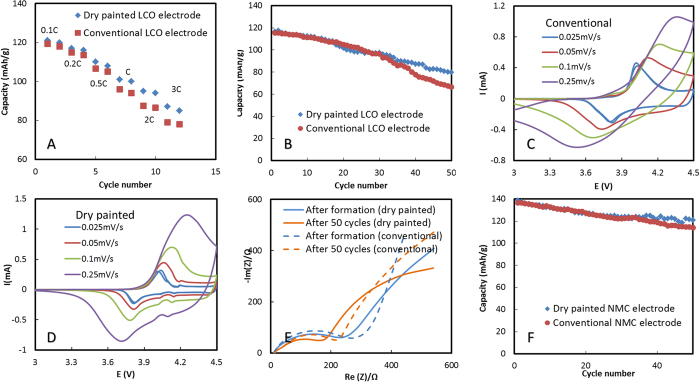
Electrochemical Characterization.(A) C-rate performance of the dry painted and conventional LiCoO2 (LCO) electrodes, (B) cycling performance comparison between the dry painted and conventional LCO electrodes; (C) Cyclic Voltammetry of conventional LCO electrodes; (D) Cyclic Voltammetry of dry painted LCO electrodes; (E) Comparison of electrochemical impedance spectra between dry and conventional LCO electrodes; (F) Cycling performance of the painted and conventional LiNi1/3Mn1/3Co1/3O2 (NMC) electrodes.